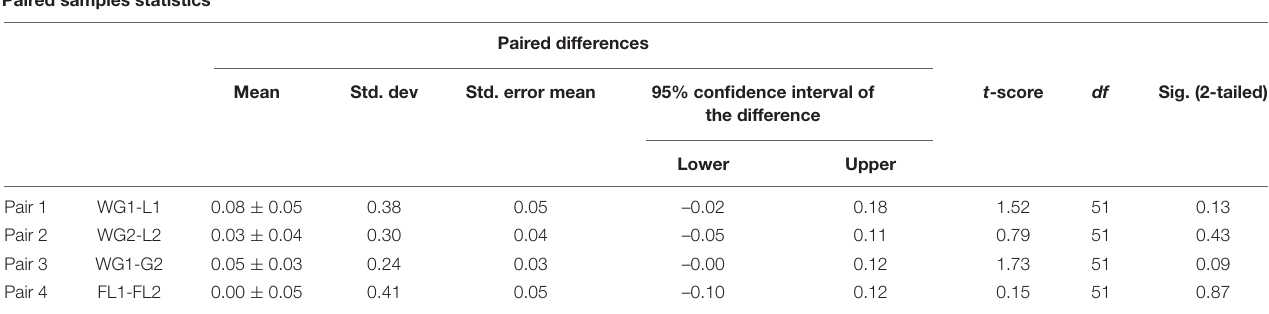
TABLE 6A | Paired sample statistics and paired samples test showing mean difference and standard deviation. Paired samples statistics